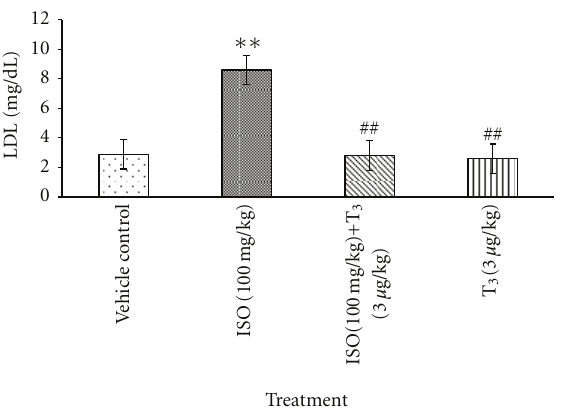
Figure 1: E ff ect of T 3 on low-density lipoprotein, values are presented as Mean ± SD, n = 5, ∗∗ : significant from control group at 1% level ( P < 0 . 01), ## : significant from ISO control at 1% level ( P < 0 . 01), SD: Standard